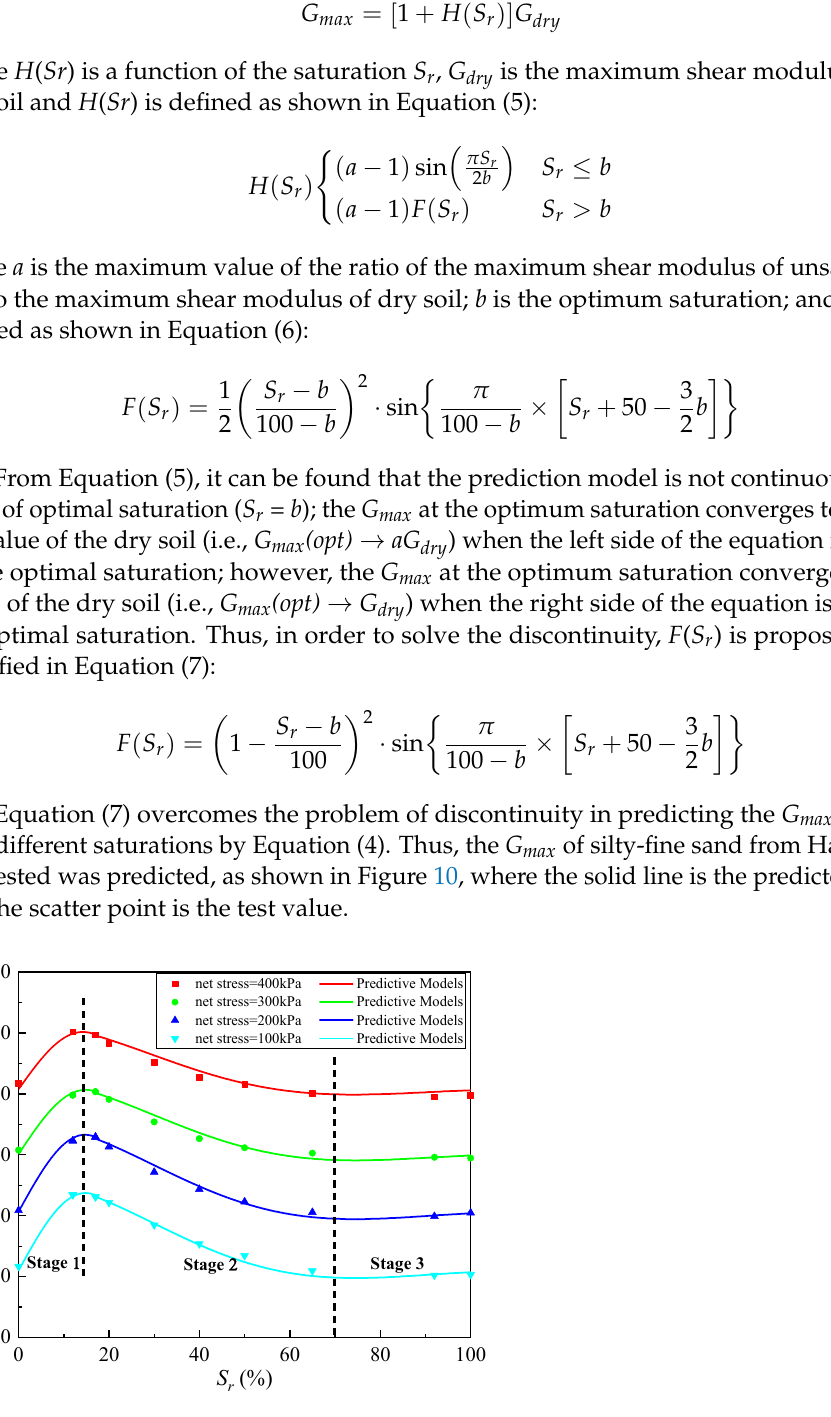
Figure 10. The prediction of G ma x under different net stresses, Stage 1: unsaturated residual stage; Stage 2: transition stage; Stage 3: boundary effect stage.